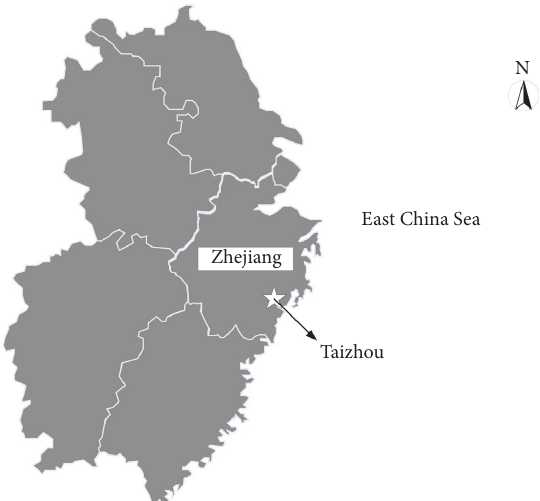
Figure 1: Location of Taizhou.